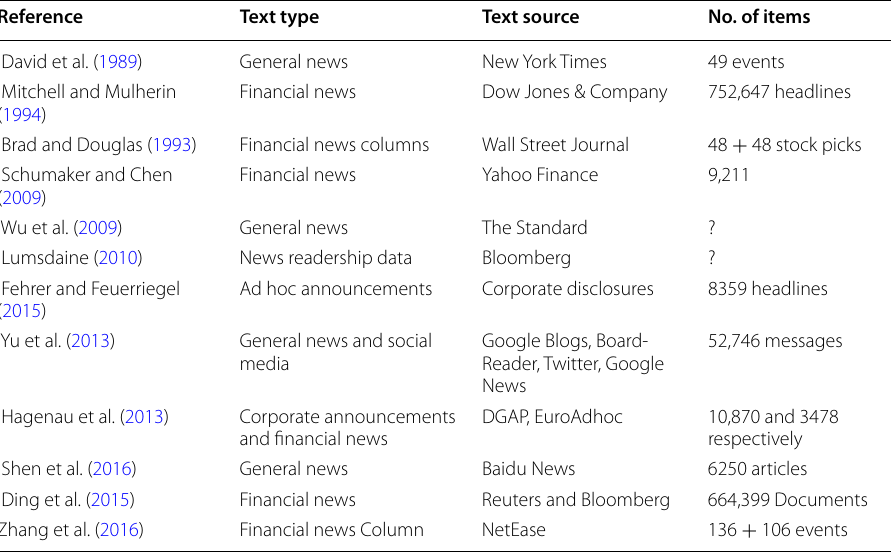
Table 1 Textual Input Data in related studies of the connection between news and financial